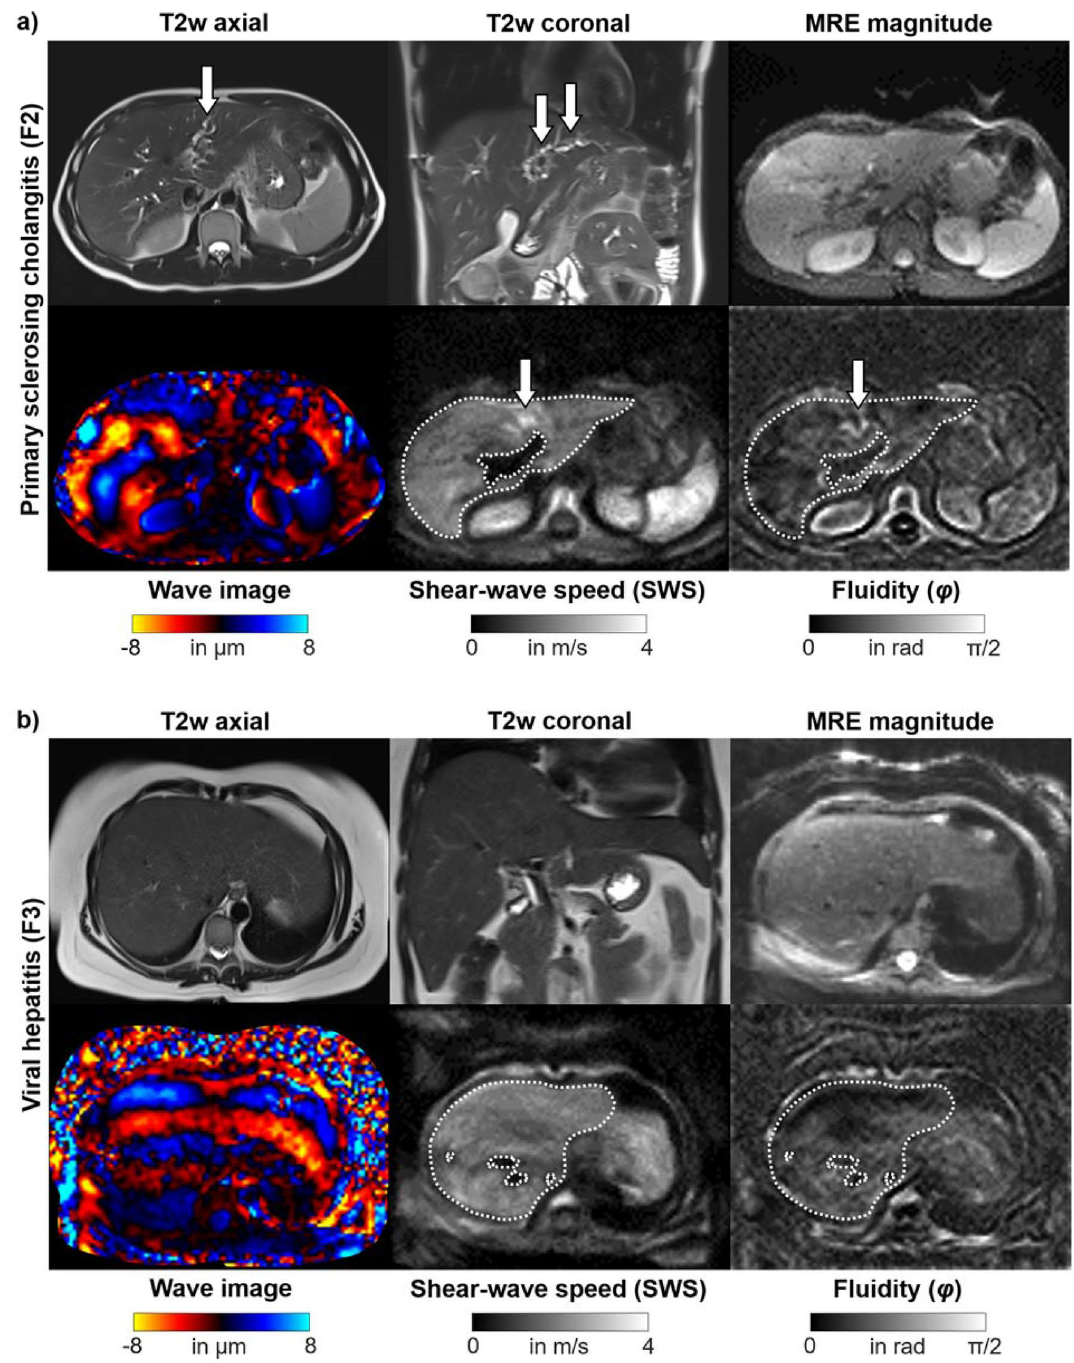
Figure 2. Representative cases. ( a ) 36-year-old man with primary sclerosing cholangitis (PSC) and moderate fibrosis (stage F2). There is irregular intrahepatic biliary dilatation in segments II and IV (arrows) on axial and coronal T2w images. MRE magnitude: morphological magnitude image derived from the magnetic resonance elastography (MRE) sequence. The wave image displays tissue displacement into and out of the axial plane. The full-field-of-view elastograms are quantitative grayscale maps of shear-wave speed (SWS) and fluidity ( φ ). In the region of interest (white dashed lines), the patient shows SWS and φ values with corresponding coefficient of variation (CV) of 1.56 m/s and 18%, and 0.62 rad and 32%, respectively. A rather heterogeneous PSC-related fibrosis distribution with a focal increase in stiffness in the area of irregular biliary dilatation in segment II and IV is visually apparent (arrows). ( b ) 32-year-old woman with viral hepatitis B with SWS and φ values with corresponding CV of 1.69 m/s and 17%, and 0.45 rad and 41%, respectively. Despite severe fibrosis (stage F3), both the stiffness and the fluidity map show a rather homogenous viral hepatitis-related fibrosis